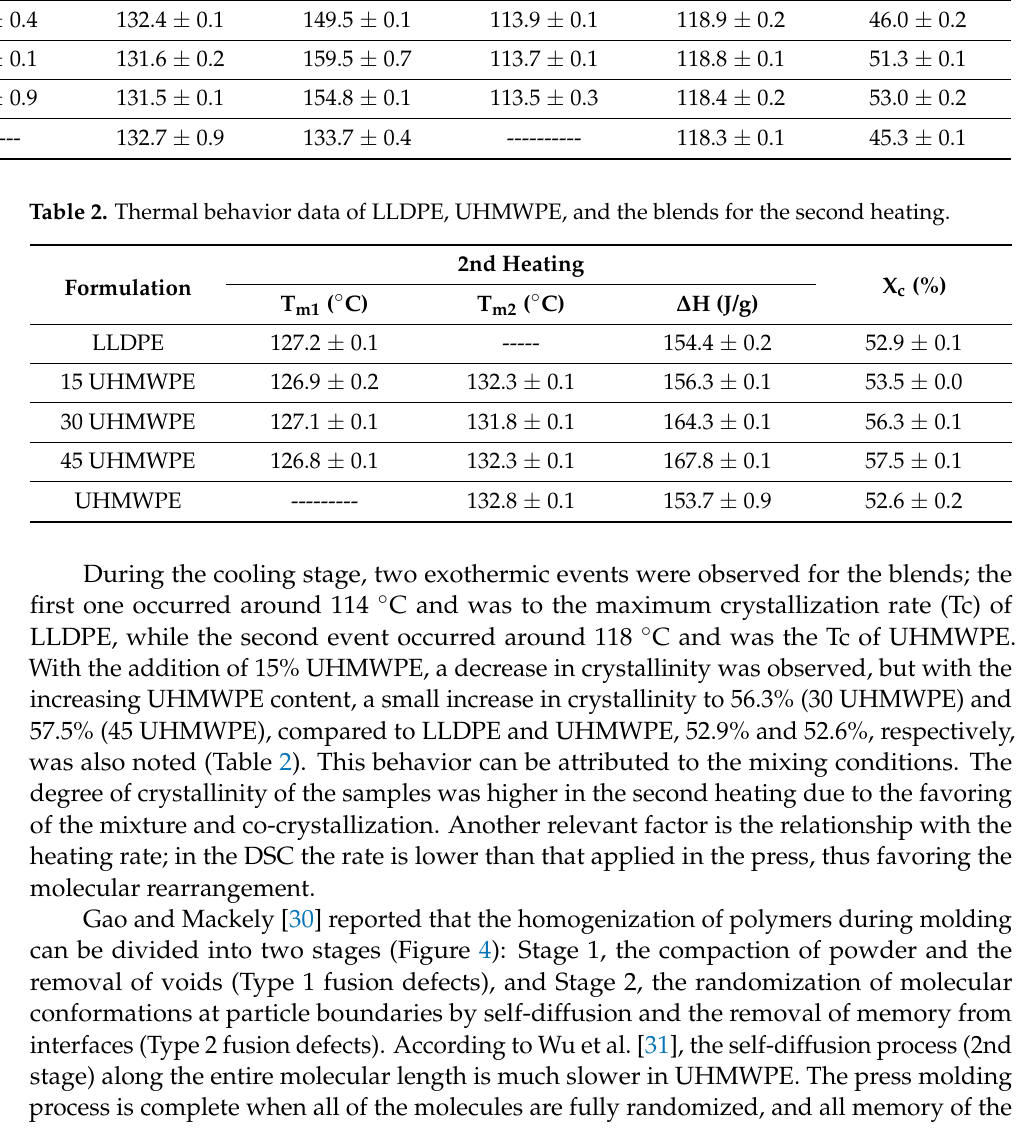
Table 1. Thermal behavior data of LLDPE, UHMWPE, and blends for first heating and cooling. 1st Heating Formulation